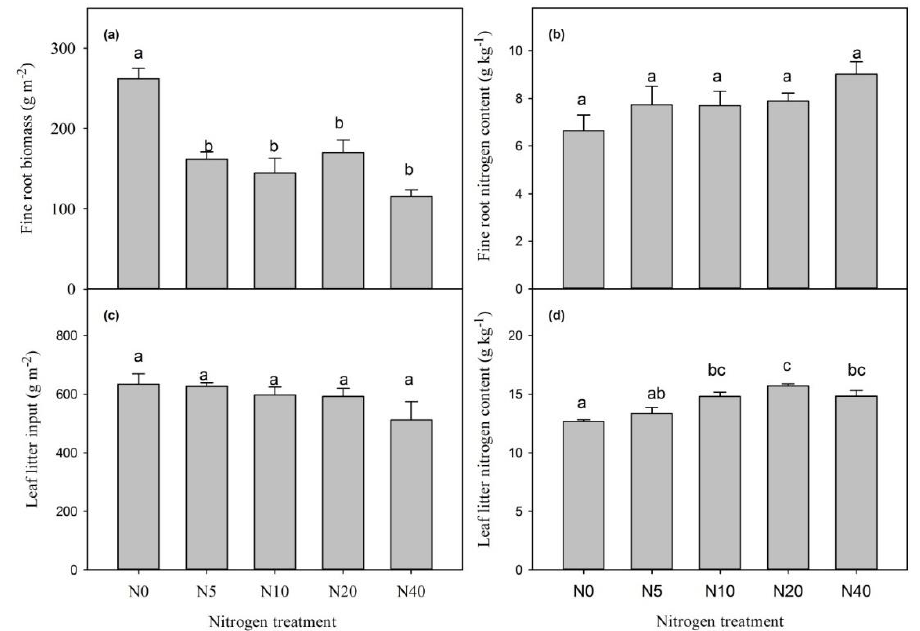
Figure 3. Variations in fine root biomass ( a ), fine root nitrogen content ( b ), leaf litter input ( c ), and leaf litter nitrogen content ( d ). Different lowercase letters above bars represent a significant difference ( p < 0.05, n = 4) among the five nitrogen addition rates.